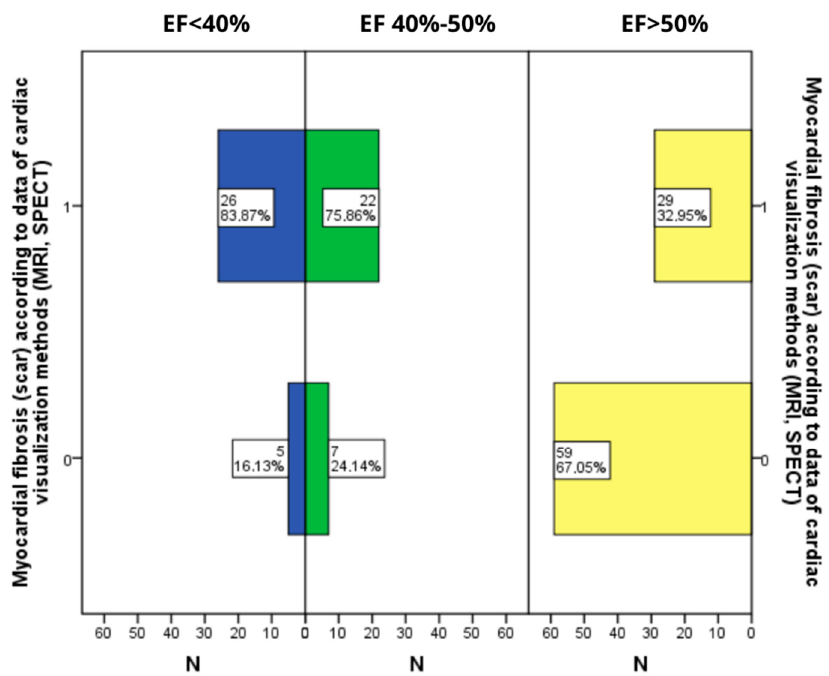
Figure 1. N—number of observations, EF—ejection fraction of the left ventricular, MRI—magnetic resonance imaging, SPECT—single photon emission computed tomography; 0—there is no fibrosis (scar); 1—there is fibrosis